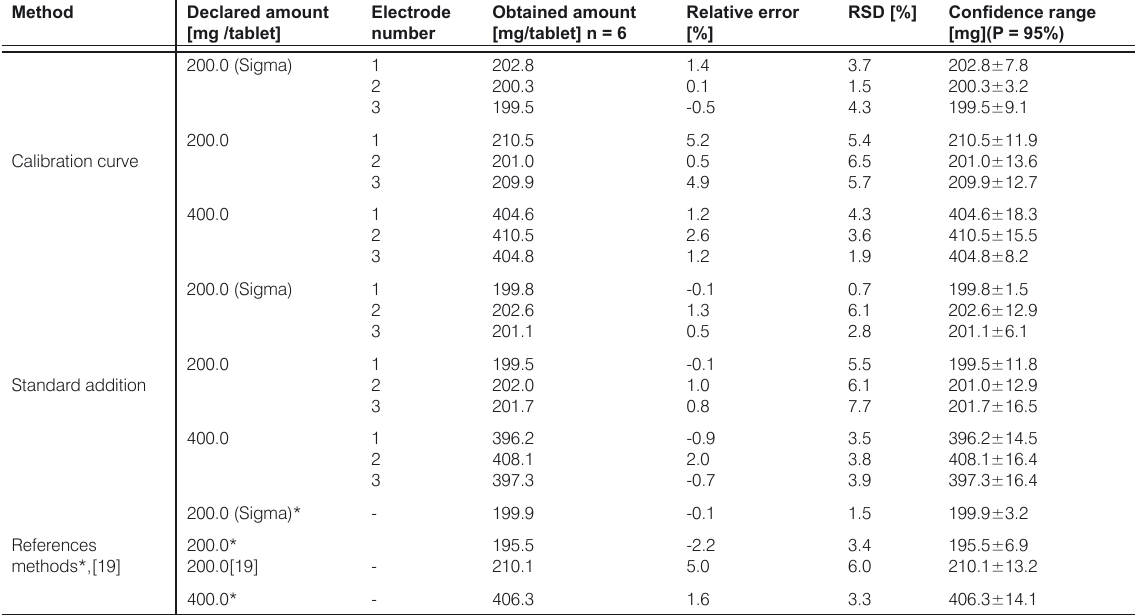
Table 6. Ibuprofen determination